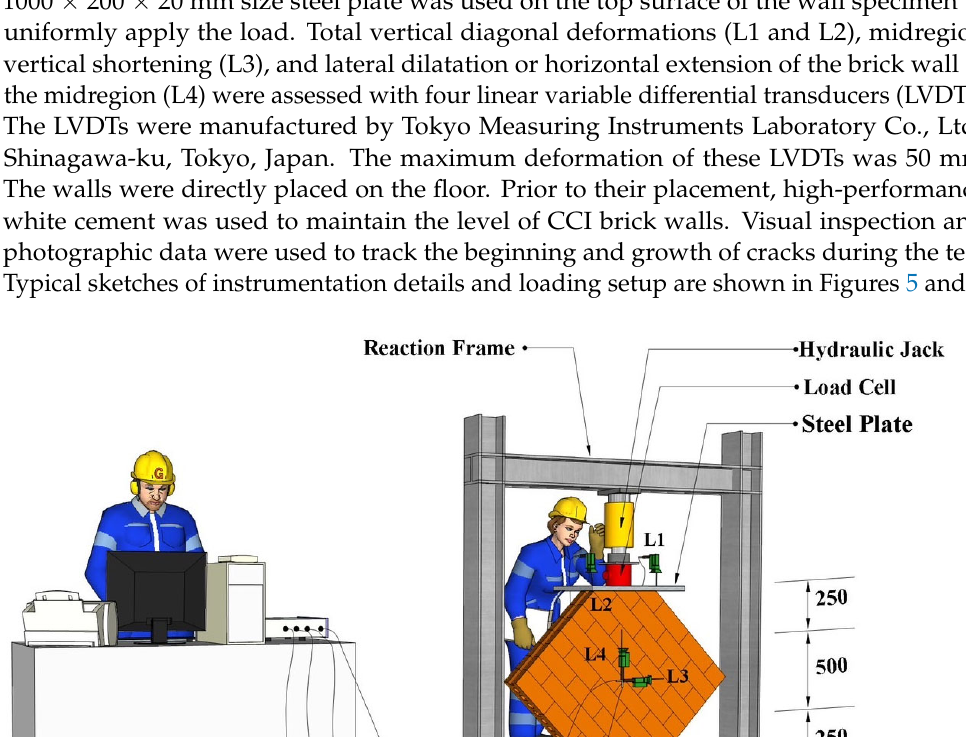
Figure 4. CS Mortar Strengthening: ( a ) Details of CS Mortar Strengthening; ( b ) CS mortar strength ‐ ened wall.